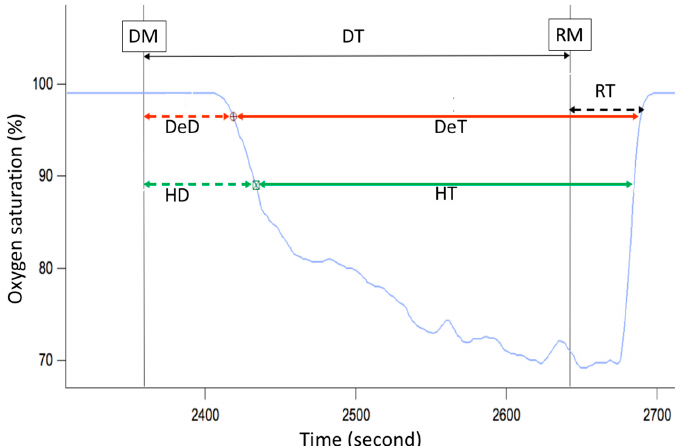
Figure 13. Phases of the oxygen saturation curve (blue line) during a simulated flight. DT—disconnection time (black arrow), DeD—desaturation delay (dashed red arrow), HD—hypoxia delay (dashed green arrow), DeT—desaturation time (solid red arrow), HT—hypoxia time (solid green arrow), RT—recovery time (dashed black arrow), DM—disconnection from oxygen mask, RM—reconnection to oxygen mask.